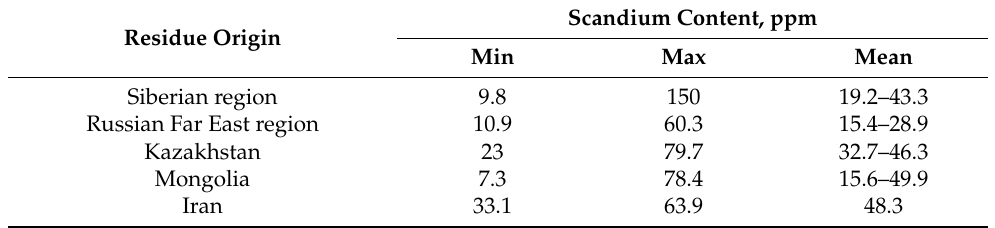
Table 3. Scandium content in the coal ashes reported by